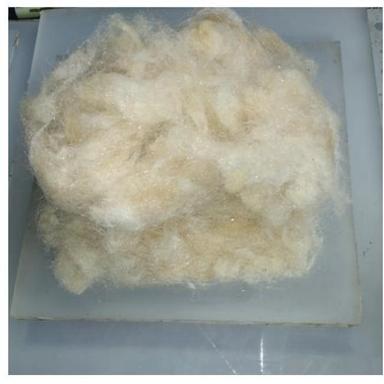
drying of sheep wool. in this research.